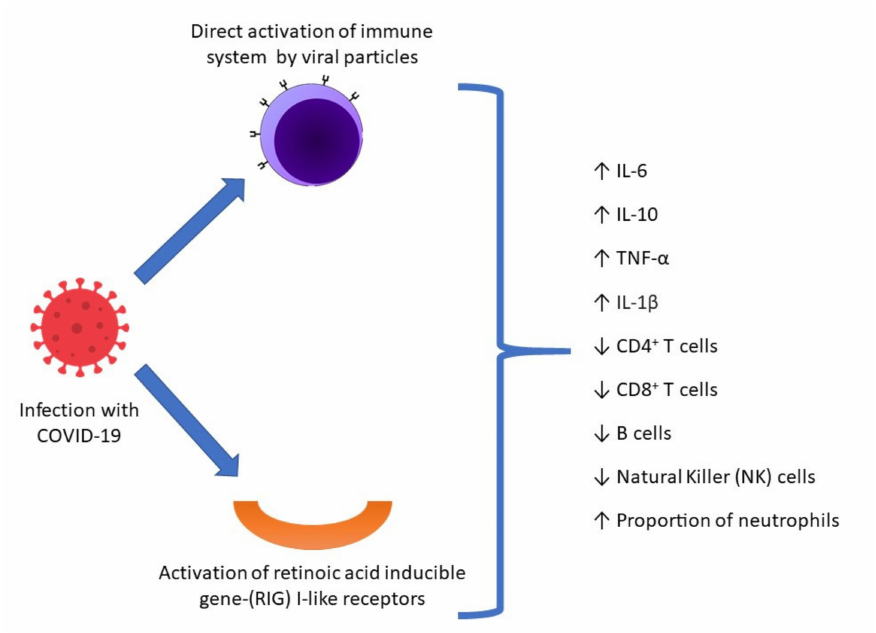
Figure 1. Hyperimmune response in COVID-19. COVID-19 may trigger a dual immune response, both through direct activation of the immune system by viral particles and by activation of the immune-promoting retinoic acid inducible gene-(RIG) I-like receptors (RLRs) and subsequent release of retinoic acid and retinyl esters into circulation. The hyperimmune response in COVID-19, charac- terized by elevated inflammatory markers and lymphopenia, particularly of cytotoxic lymphocytes, and relative preponderance of neutrophils, may contribute to the pathophysiology of